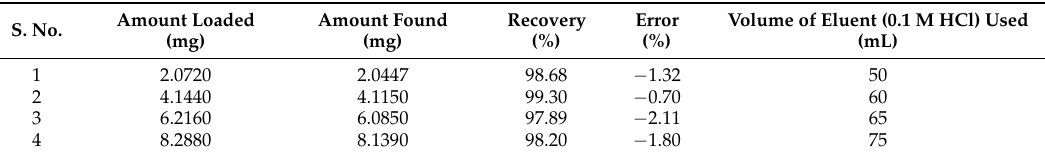
Table 7. Selective separations of Pb 2+ ions from a synthetic mixture of Pb 2+ , Ni 2+ , Cd 2+ , and Mg 2+ ions on a column of graphene Th(IV)